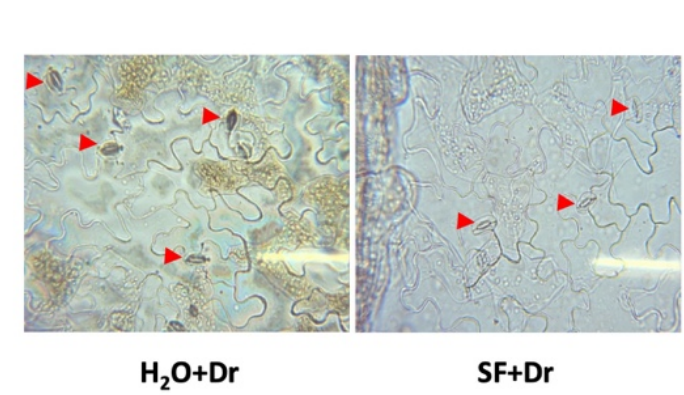
Figure 6. Stomatal closure response under drought. ( a ) Stomatal apertures in SF-primed and unprimed plants with the progression of drought stress. Note that, under well-watered conditions, SF priming (SF+H 2 O) leads to partial stomatal closure compared to nonprimed plants (H 2 O+H 2 O). Under conditions of drought stress, partial stomatal closure occurred earlier in SF-primed plants (SF+Dr) than in nonprimed plants (H 2 O+Dr). Error bars indicate standard error of the mean (SEM), n ≥ 250; treatments sharing different letters indicate significant differences from each other ( p < 0.05; one-way ANOVA, Tukey’s multiple comparison test). ( b ) Relative expression of PRX34 in SF- primed and unprimed plants. Values are expressed as fold change (FC) in expression normalized to those determined in unprimed, well-watered (H 2 O+H 2 O) controls. Asterisks represent significant differences in expression in unprimed drought-stressed (H 2 O+Dr) vs. primed (SF+Dr and SF+H 2 O) plants ( p < 0.0001; one-way ANOVA, Tukey’s multiple comparison test). ( c ) Histochemical staining assay for ROS accumulation in leaf stomata. Leaf epidermal peels from plants (unprimed and primed) under drought stress were used for DAB staining following a reported protocol [74]. Red arrow heads indicate stomata. Dr, drought stress; SF, Super